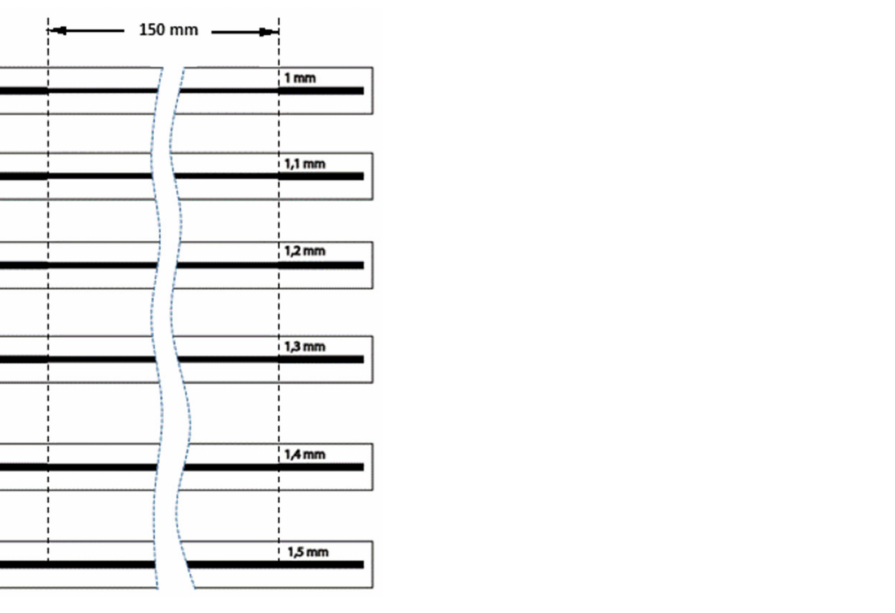
Figure 10. Dimensions of the pattern used to determine the parameters of elongation of inks and base films.